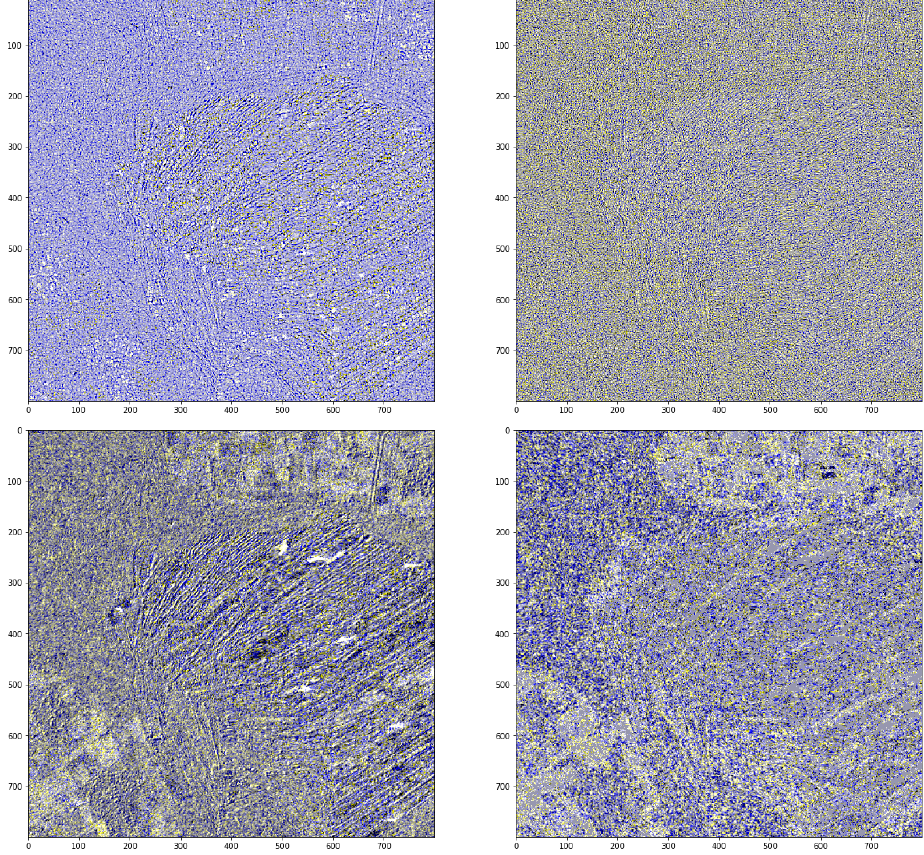
Figure 8. RGB composite ratios ( R = G = | S vv | 2 / | ˆ S vv | 2 , B = | S vh | 2 / | ˆ S vh | 2 ) of the target image to the refined Lee filter ( upper left ), the Gamma MAP filter ( upper right ), the EMD filter ( lower left ), and the ATSF ( lower right ) for the same spatial subset as Figure